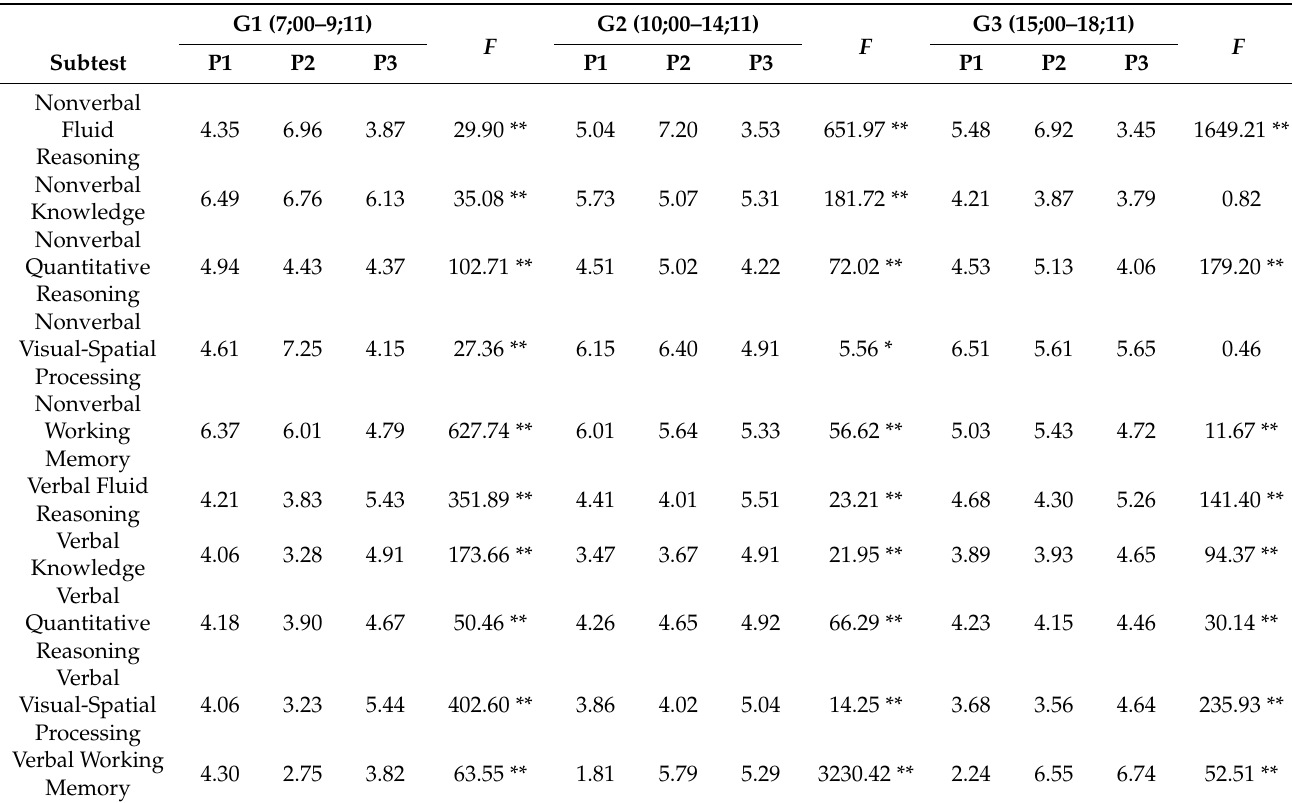
Table 2. Cluster centers (the arithmetic mean of all the observations belonging to the cluster) for 10 SB5 subtests on a standardized scale of